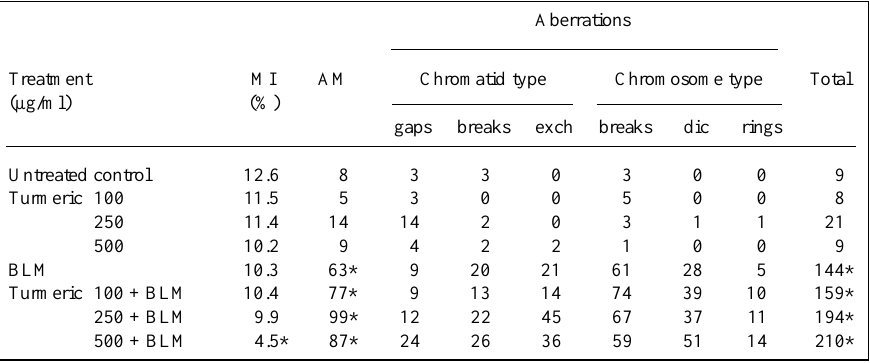
Table I - Distribution of the different types of chromosomal aberrations in 300 cells analyzed per group of treatment and mitotic index y (MI) observed in CHO cells after treatment with turmeric (13 h) and/or bleomycin (BLM, 10 µg/ml) during G /S 1